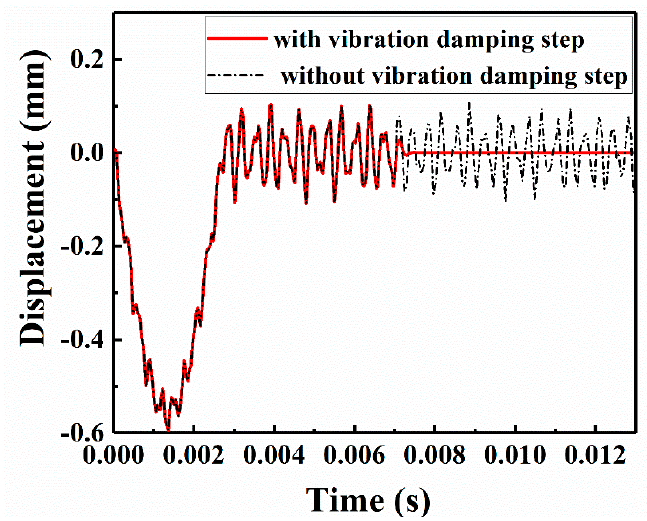
Figure 17. Effectiveness of the vibration damping step on the upper surface of the repaired CFRP laminate.